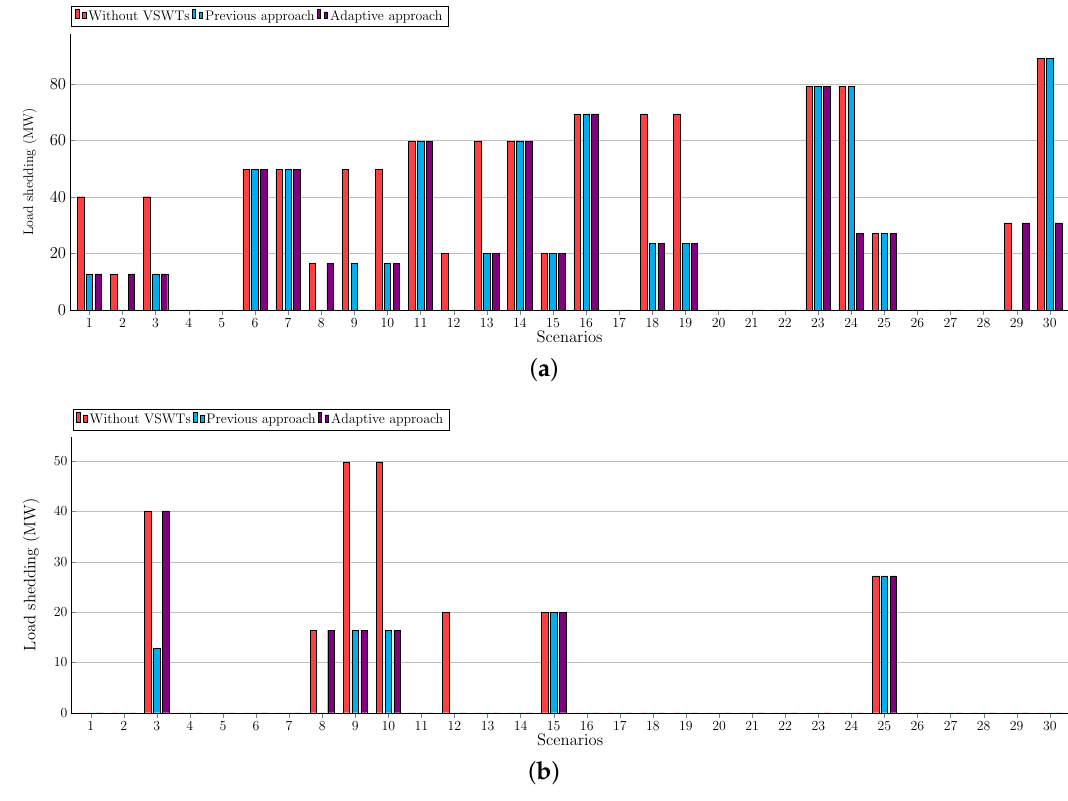
Figure 11. Load shedding ( a ) Largest power plant disconnection; ( b ) Second largest power plant